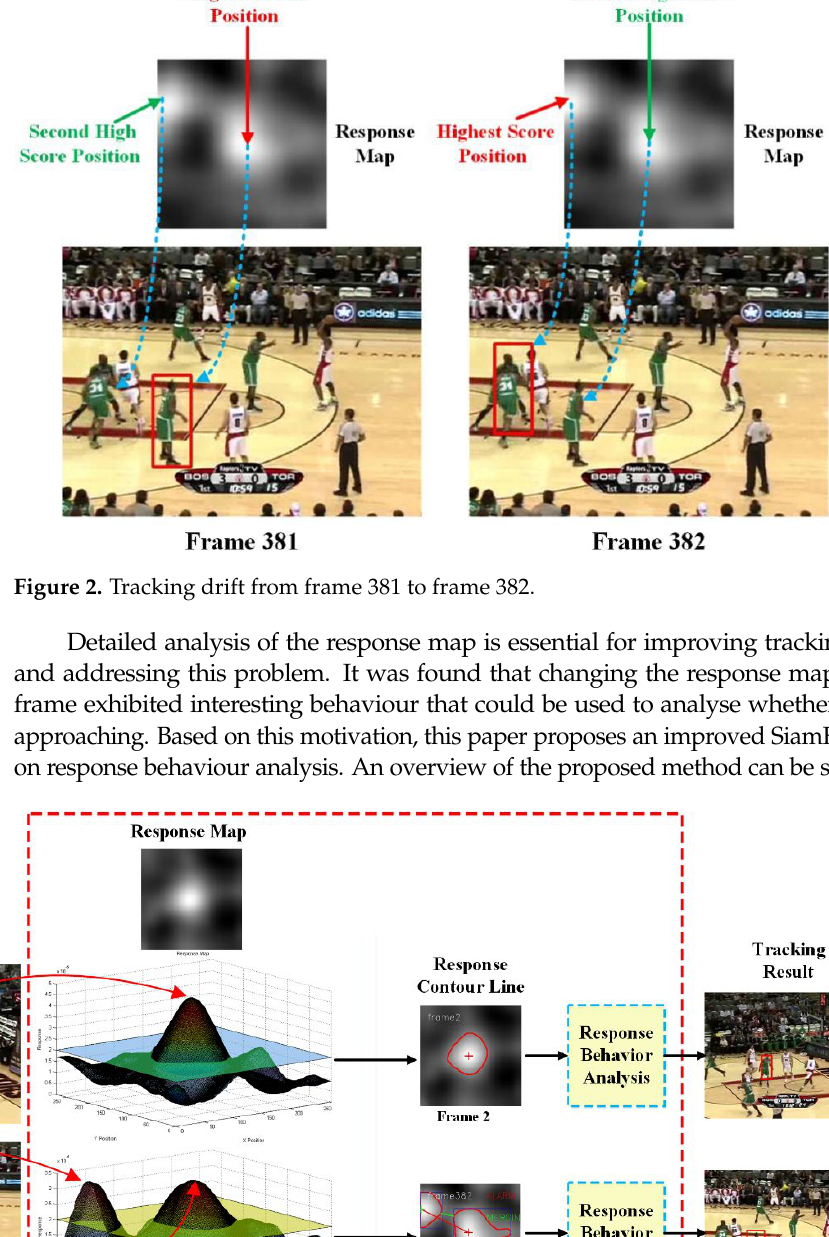
Figure 3. Overview of the proposed response analysis.